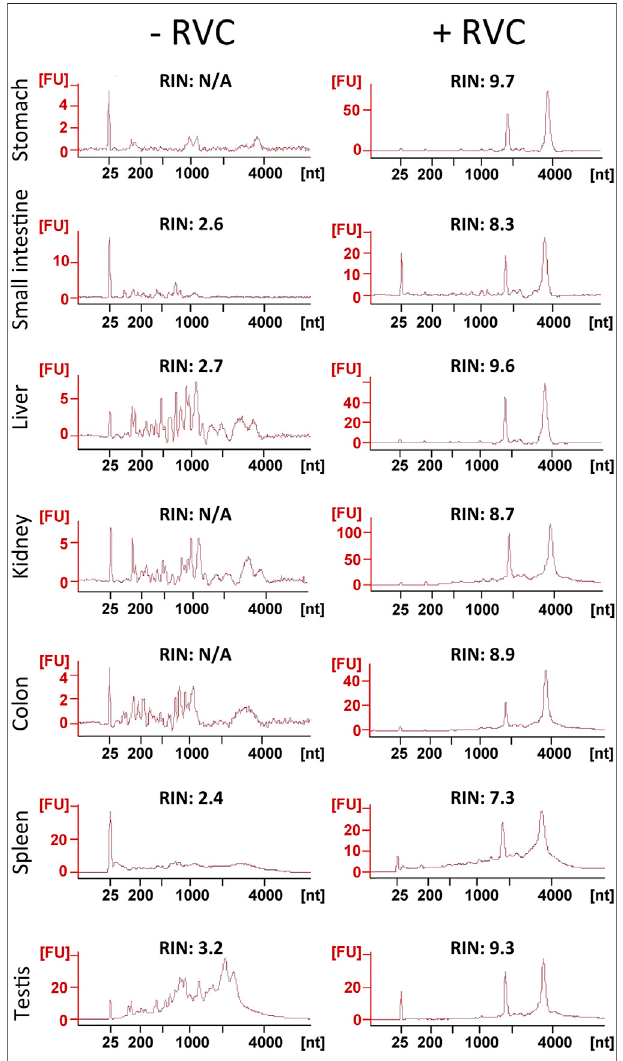
FIGURE 3 | Assessment of RNA quality from sections of various snap-frozen mouse tissues after the standard immunolabelling procedure (details in the text) in the presence or absence of 10 mM RVC. As shown by the RIN values, RVC provided superb RNA protection in all of these RNase-rich tissues during the lengthy immunolabelling